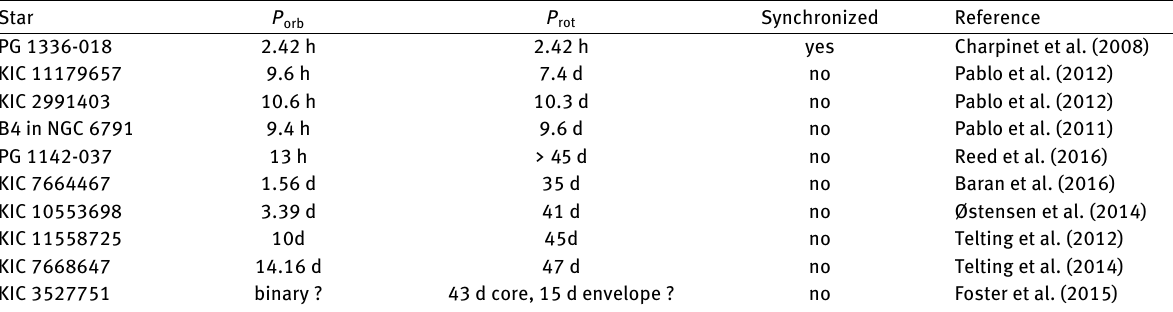
Table 1. List of pulsating sdB stars in close binary systems with a rotation period estimated from asteroseismology.